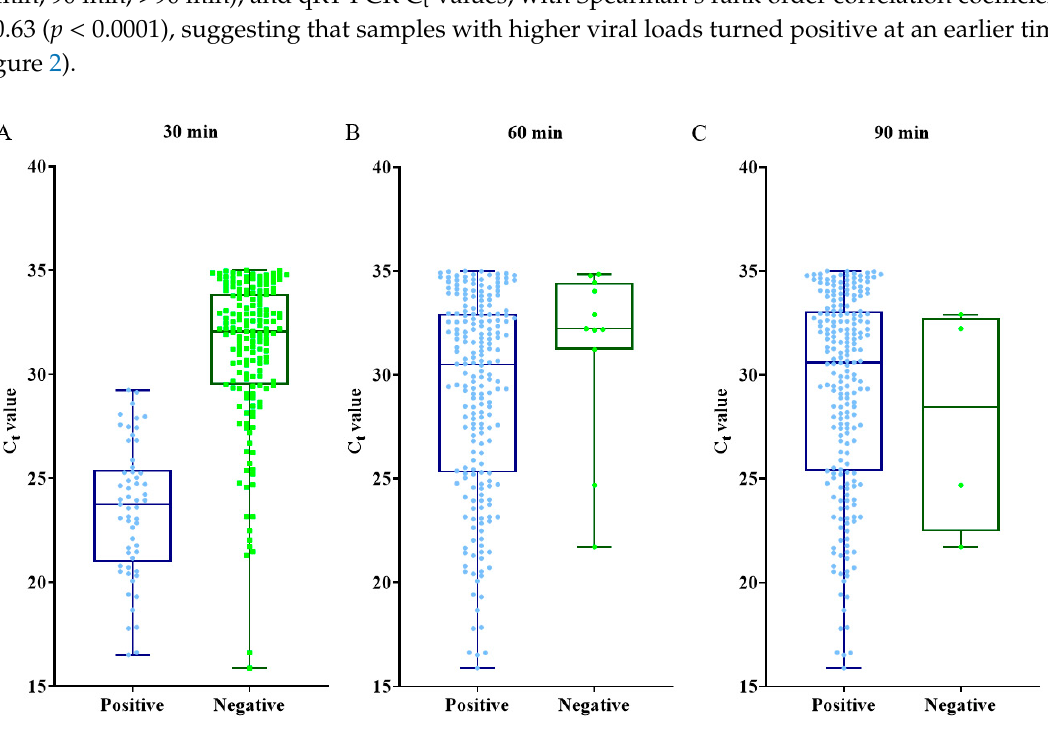
Figure 2. Box and whisker plot of COVID-19-LAMP results. The COVID-19-LAMP results of each SARS-CoV-2 qRT-PCR positive samples have been illustrated in the box and whisker plot at ( A ): 30 min, ( B ): 60 min, ( C ): 90 min with corresponding qRT-PCR C t values of samples.